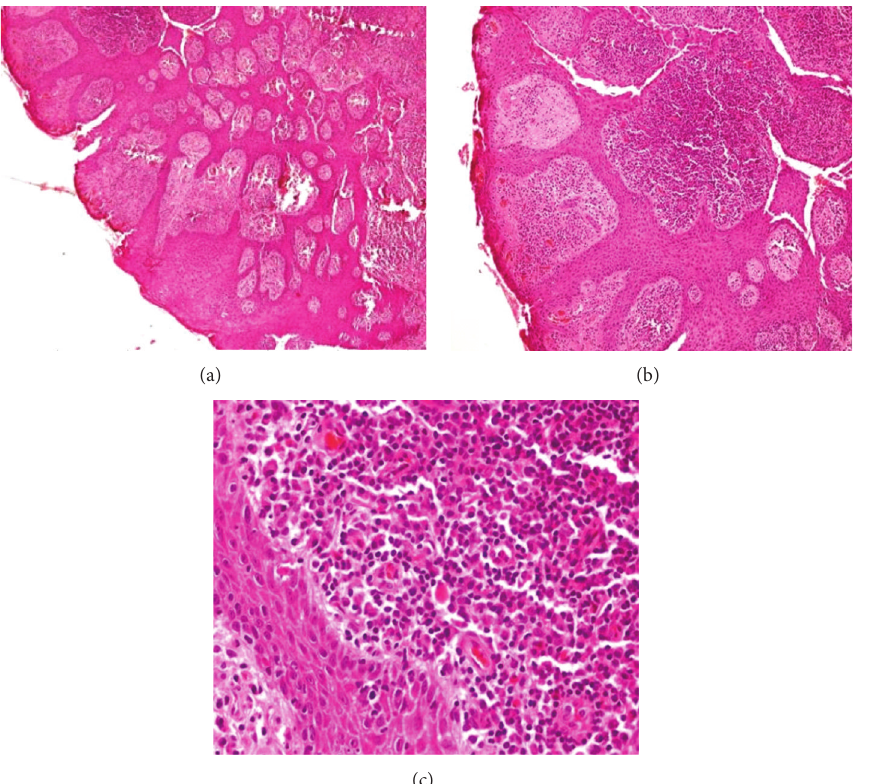
Figure 2: Haematoxylin and eosin stain. (a) The surface is lined by stratified squamous epithelium showing pseudoepitheliomatous hyper- plasia. ( × 100). (b) The lining epithelium does not show any dysplasia or malignancy ( × 200). (c) The subepithelium shows dense plasma-cell- rich inflammation ( ×